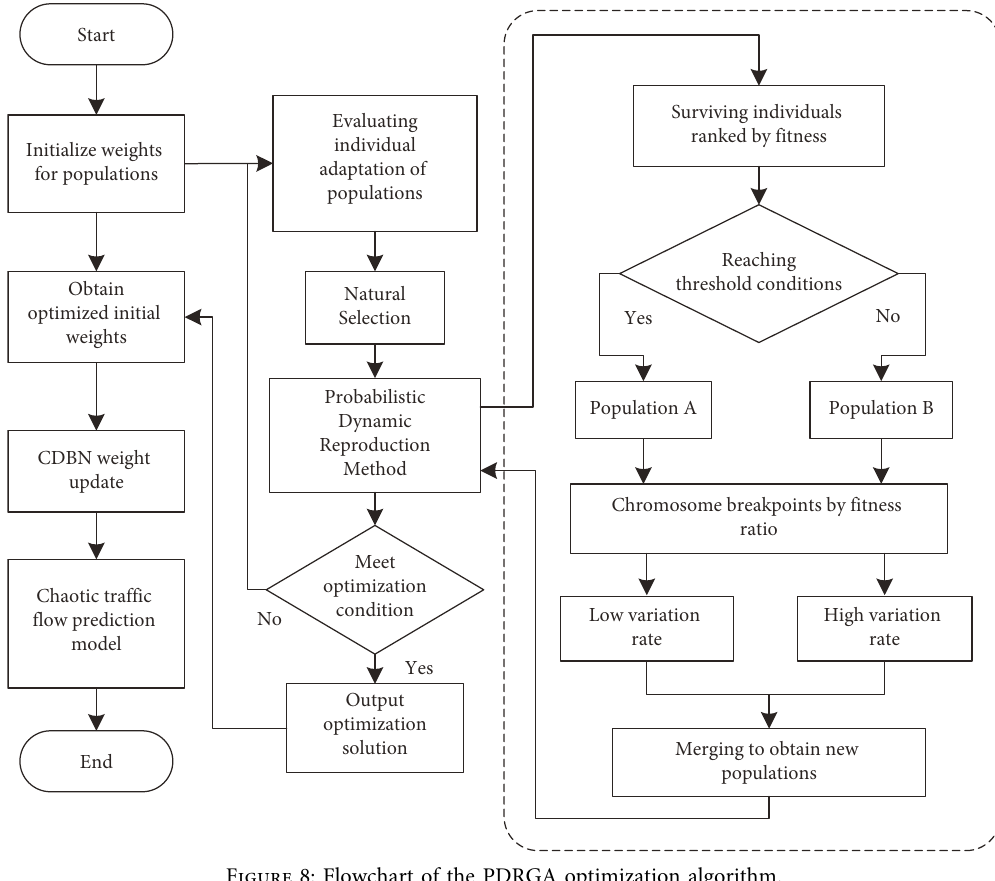
Figure 8: Flowchart of the PDRGA optimization